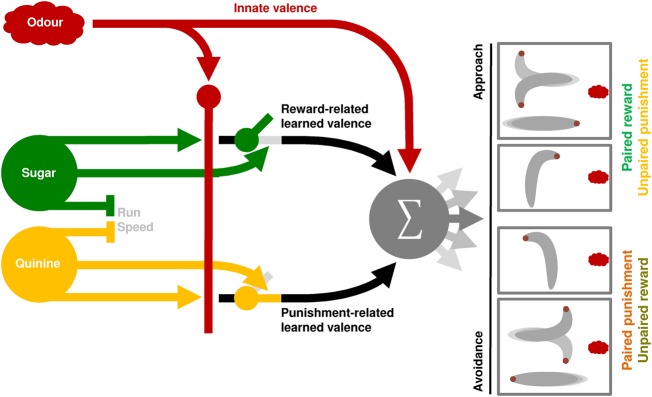
Working hypothesis for how conditioned odor aversion and approach come about. Both sweet and bitter substrates reduce run speed. Odor valence is formed by the sum of the odor's innate valence (which is usually positive in the case of larval Drosophila) and learned valence resulting from associative memory (see also Wystrach et al. 2016). Learned valence can be negative after paired aversive or unpaired appetitive training, and positive after unpaired aversive or paired appetitive training. Notably, signaling of learned valence after appetitive training (be it positive or negative) is blocked by the presence of the reward. Learned valence after aversive training, in contrast, is signaled only in the presence of the punishment. Signaling of innate valence is not affected by the presence of reward or punishment (see also Supplemental Fig S2A). After paired aversive or unpaired appetitive training, a negative learned valence is added to the innate valence of the odor, which may in sum lead to conditioned aversion. Consequently, more HCs are performed while heading toward the odor than while heading away, and HCs are directed away from rather than toward the odor. Notably, if the positive innate valence of an odor happens to be higher than the learned negative valence, larvae may not show net aversion (Schleyer et al. 2015b). After unpaired aversive or paired appetitive training, the summed innate and learned valences may lead to approach through a bias toward performing more HCs while heading away from the odor than while heading toward it. Moreover, HCs are directed toward rather than away from the odor.